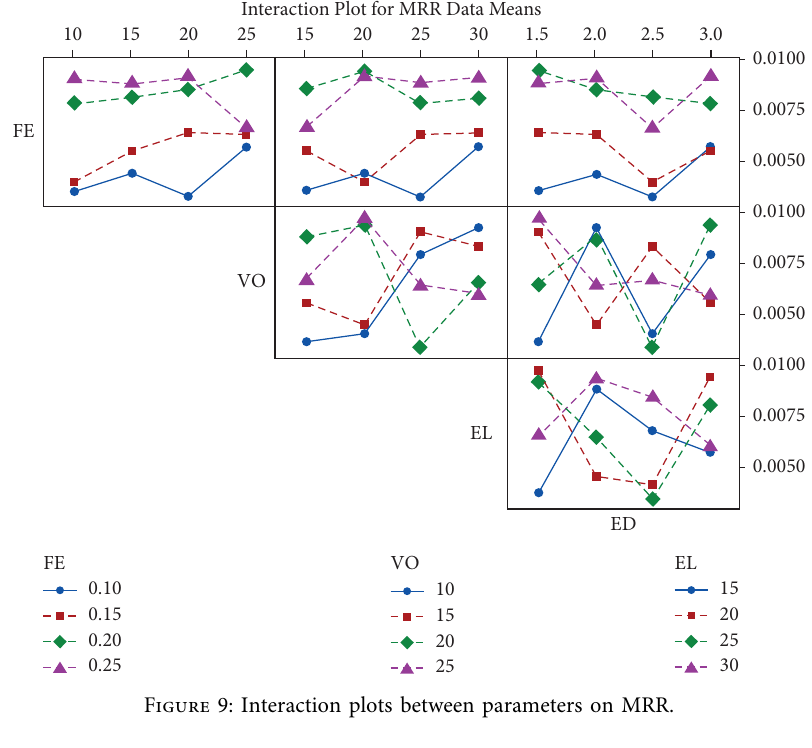
Figure 9: Interaction plots between parameters on MRR.